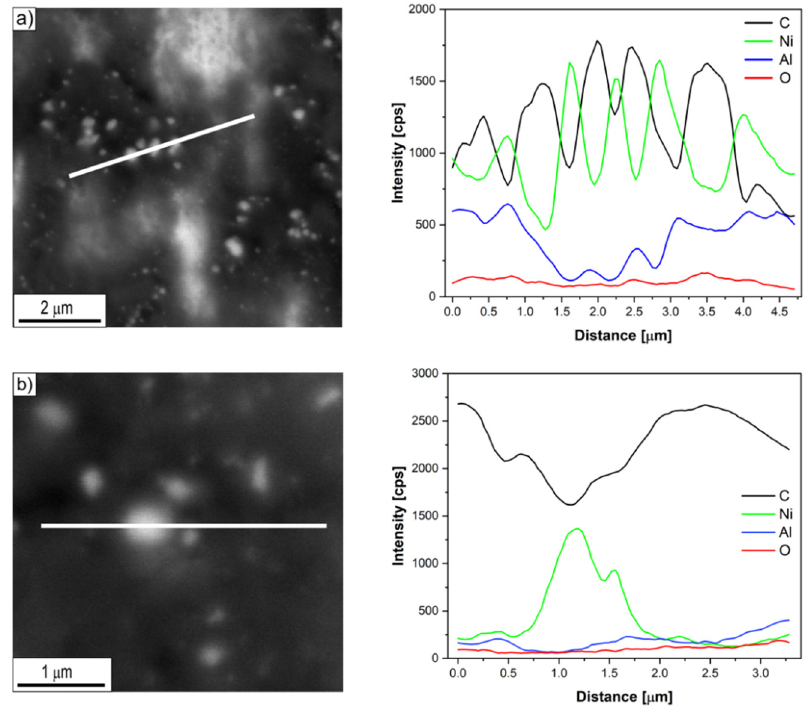
Figure 6. Linear EDS/SEM analysis of the CNT/CNF area with nickel-like nanoparticles formed after decomposition of ethanol with 0.35 vol.% addition of water vapour (mixture #2) at: ( a ) 500 and ( b ) 700 ° C.